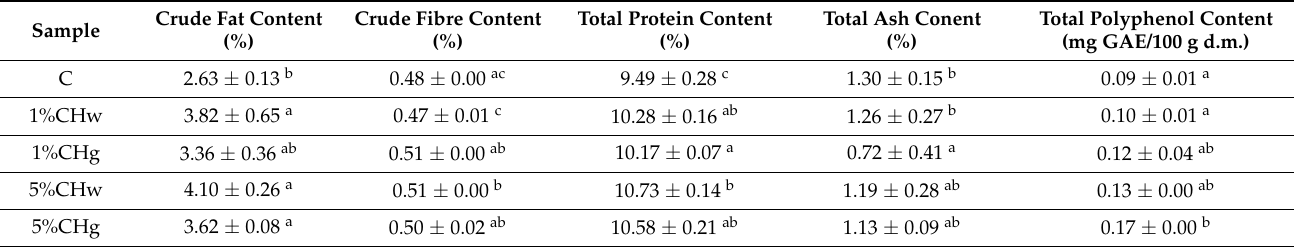
Table 4. Content of crude fat, crude fiber, protein, ash and total polyphenols content in the examined wheat bread with and without chia